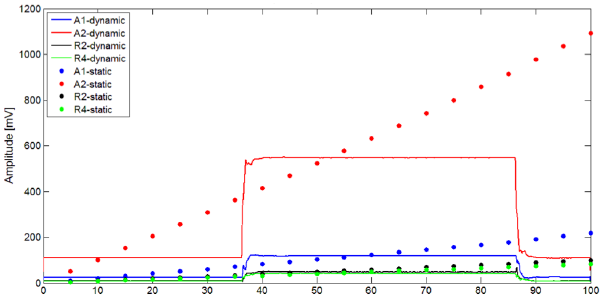
Figure 3. Multisensor bedload monitoring platform: dynamic characteristics: received signal (mV) vs. time